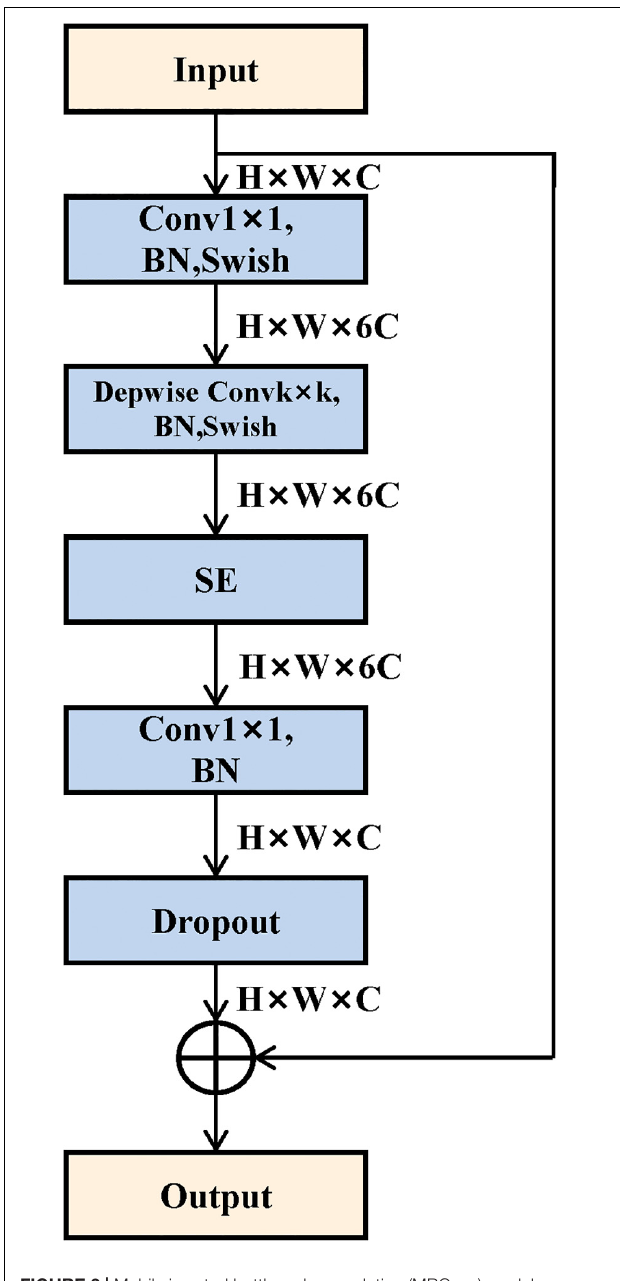
FIGURE 3 | Mobile inverted bottleneck convolution (MBConv) module structure. It mainly consists of depthwise convolution and squeeze-and-excitation